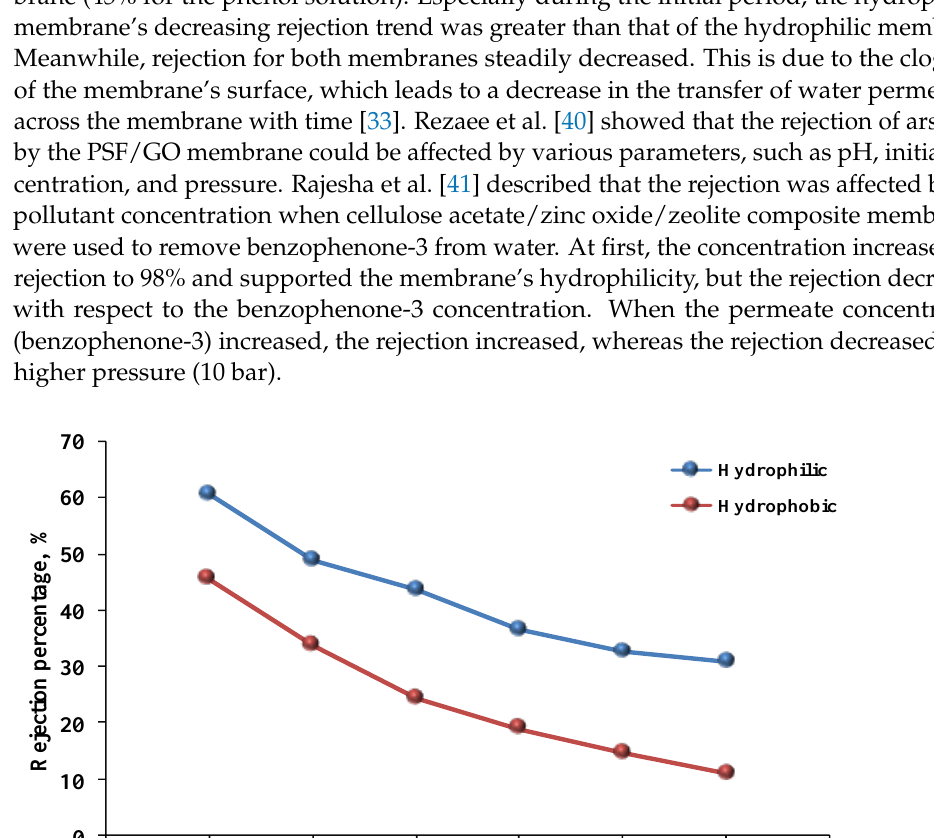
Figure 12. Flux versus time of the phenol solution for hydrophilic and hydrophobic membranes (pressure = 1 bar, temperature = 30 °C, phenol concentration = 50 mg/L).